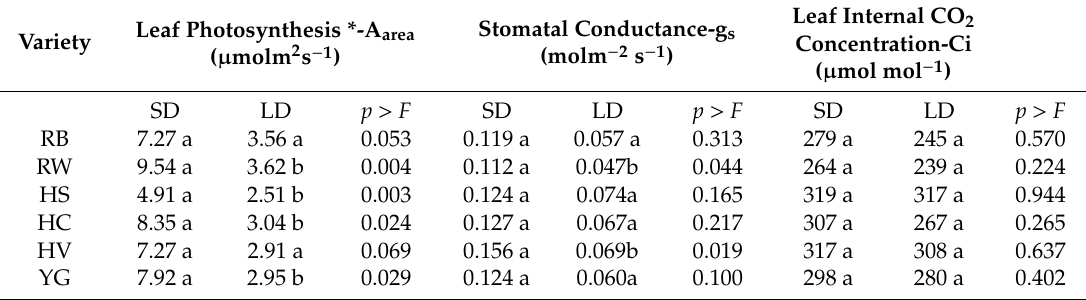
Table 2. Onion leaf physio local trait (responses) and ANOVA